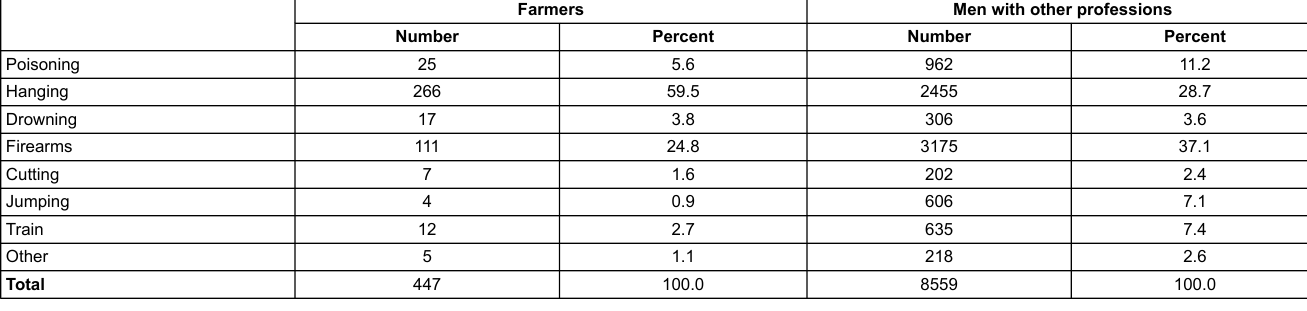
Table 4: Methods of suicide, absolute numbers and percentages for all suicides in male farmers and in men with other professions.